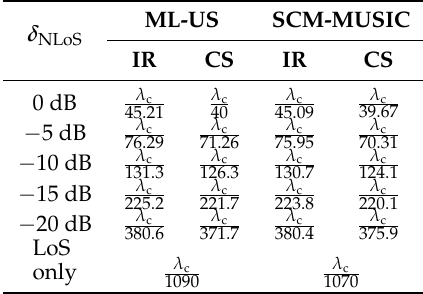
Table 2. RMSEs in the presence of multipath propagation and SNR 0 = 20 dB. IR, ideal reflector; CS, cluster of scatterers.